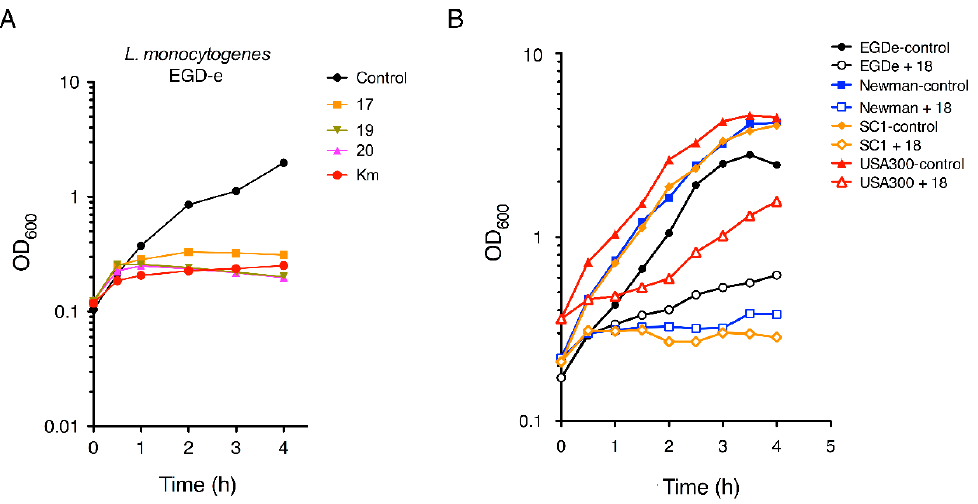
Figure 3. The aminophenol compounds arrest efficiently growth of L. monocytogenes and S. aureus . ( A ) Growth curve of a culture of L. monocytogenes strain EGD-e exposed to the indicated compounds. Time 0 in the graphic corresponds to the time the compound was added to the culture (OD600 ~0.15–0.20). All antimicrobial was used at four-fold of their respective MIC value for each of the indicated bacterial strains (see Table 1); ( B ) Growth curves of L. monocytogenes strain EGD-e and S. aureus cultures exposed to the amino phenol 18 . Amino phenol 18 was used at four-fold of its respective MIC value for each of the indicated bacterial strains (see Table 1).